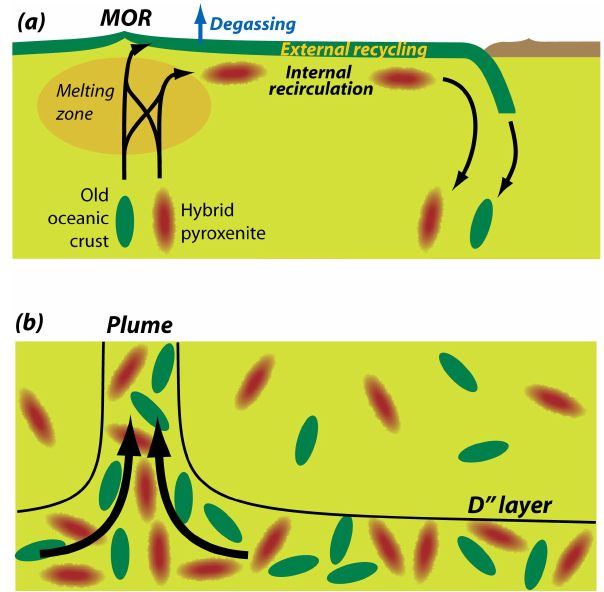
Fig. 18. Recycling through the mantle. (a) formation of oceanic crust, which degasses, and formation of hybrid pyroxenite, which does not degas. (b) Both old subducted oceanic crust and hybrid pyroxenite are denser than average mantle and would tend to accu- mulate in the D 00 region, where they might be sampled by mantle